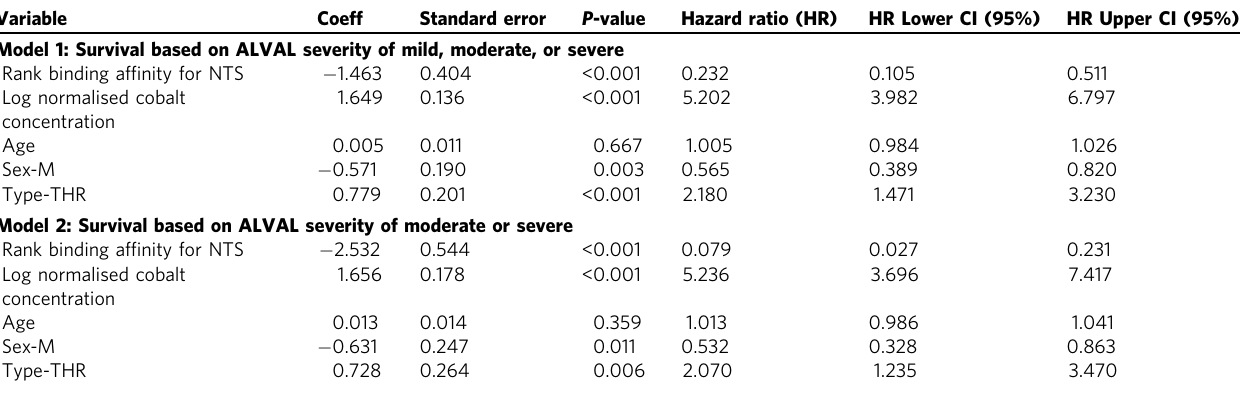
Table 2 Cox proportional hazards modelling, all 606 patients involved in the study included. Variable Coeff Standard